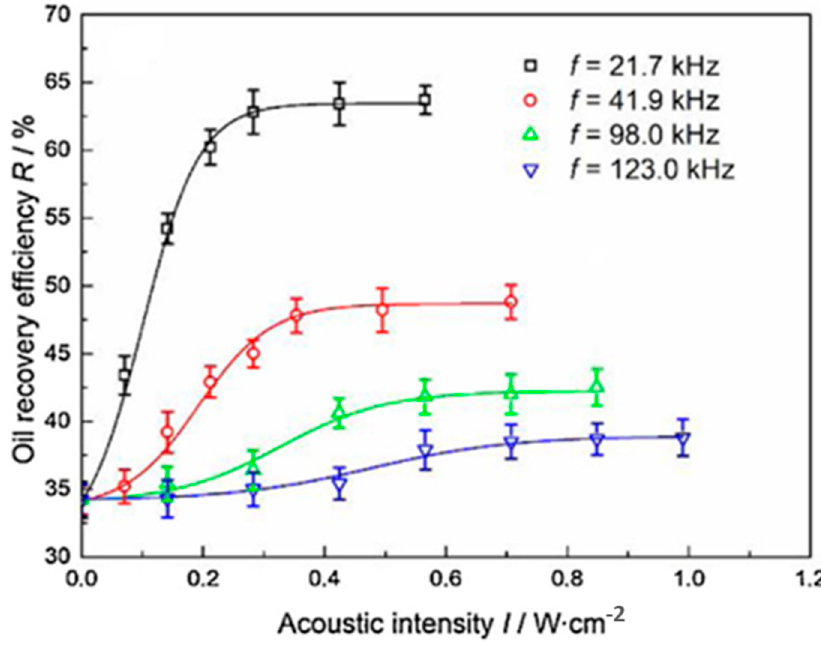
Figure 5. How acoustic properties (intensity and frequency) affect the recovery of oil (reprinted from Luo, Gong, He et al., [20] Copyright 2020, LN 5341880505665, with permission from Else- Luo, Gong, He et al. [20] Copyright 2020, LN 5341880505665, with permission from vier) .